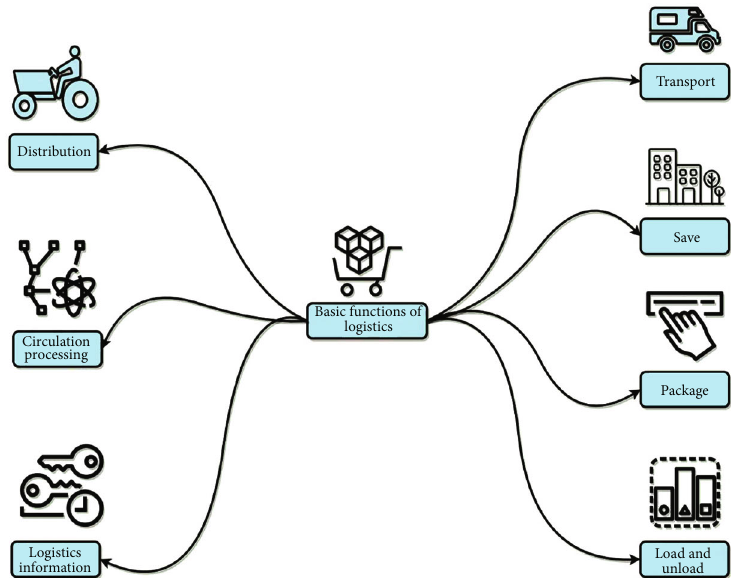
Figure 1: Basic functions of logistics system.